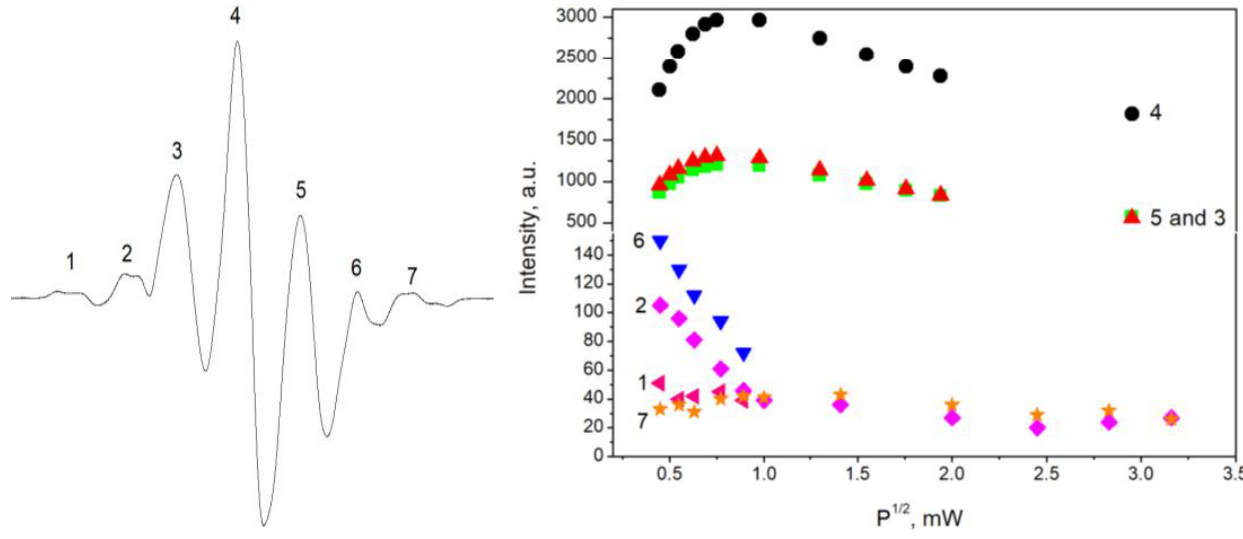
Figure 6. Saturation behaviors of the EPR lines in the spectra of proline versus the square root of the microwave power.